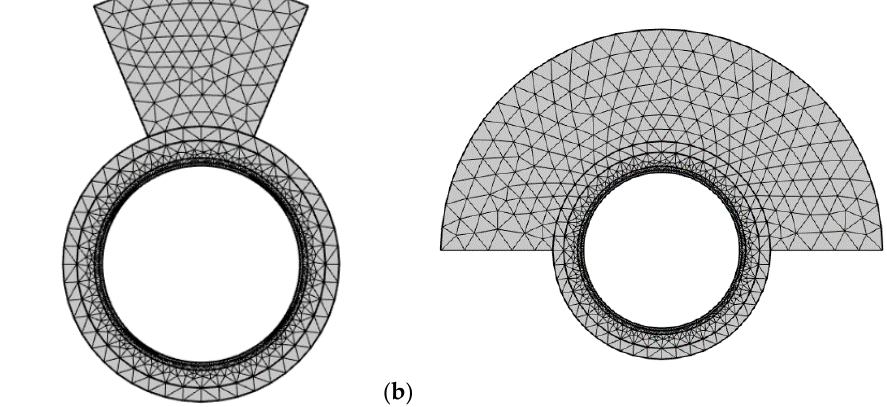
Figure 11. Fine mesh in COMSOL for ( a ) 25% ( b ) 50% mussel